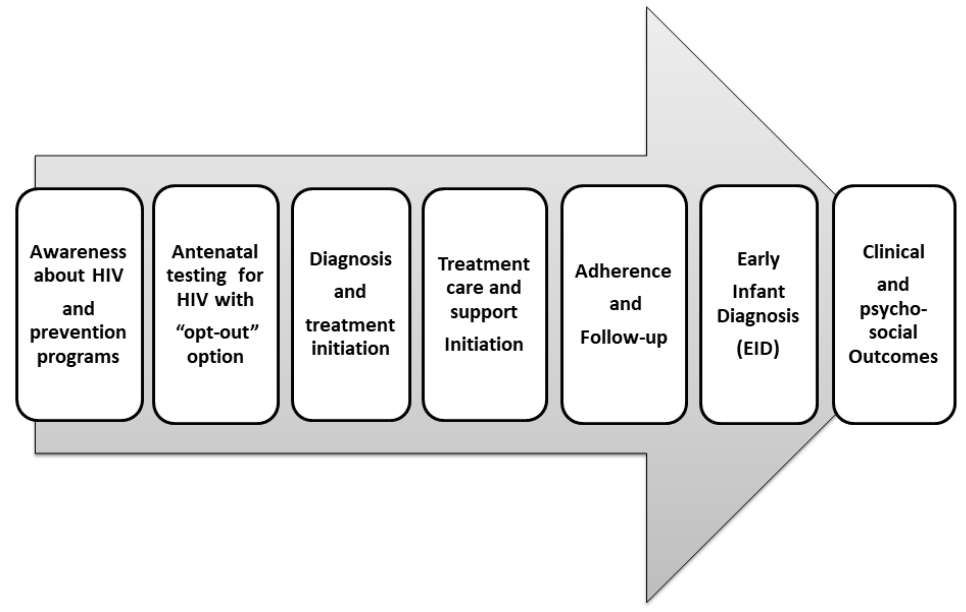
Figure 1. Prevention of Mother/Parent to Child Transmission (PMTCT/PPTCT) of HIV program cascade of care continuum.